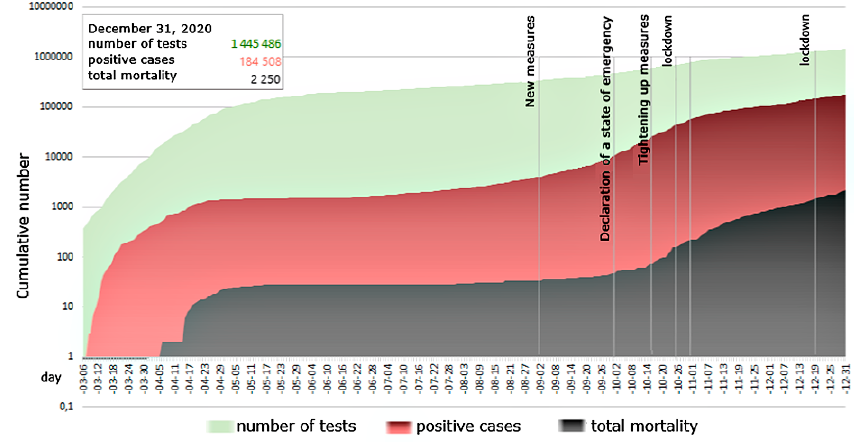
Figure 1. Cumulative number of tests, confirmed positive cases, and deaths up to 31/12/2020 Source: mapa.Covid.chat (2021), Our World in Data (2021)